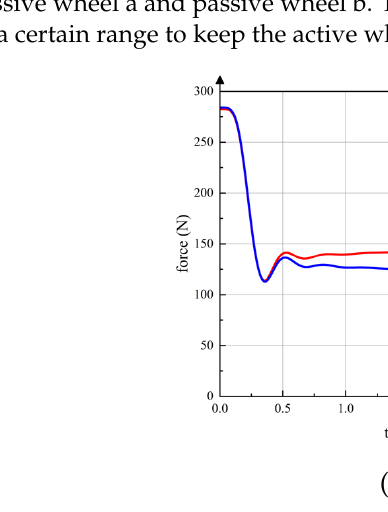
Figure 15. Vertical contact force between wheels and ground (all wheels on slope). ( a ) active wheel; ( b ) passive wheels.